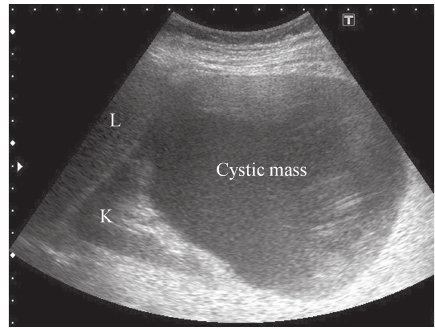
Figure 1: Ultrasonographic image of the right kidney, demonstrat- ing a 12 × 10 cm cystic mass in the lower pole of the right kidney. L, liver; K, right kidney.